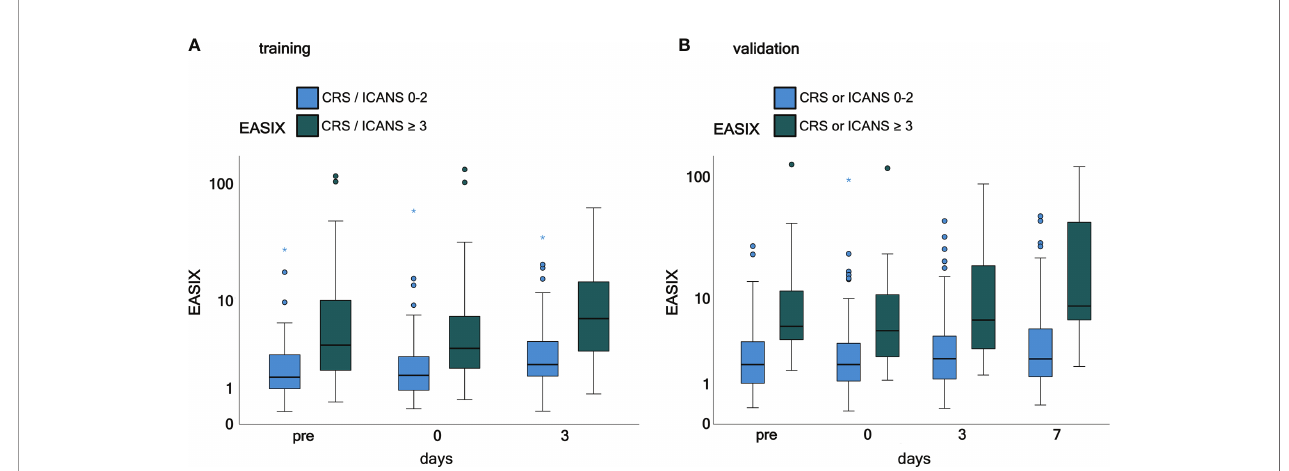
FIGURE 1 | EASIX measurement in the training and validation cohorts grouped according to CRS and ICANS grade. (A) Training cohort. (B) Validation cohort. Patients were grouped according to CRS and/or ICANS grade. EASIX prior lymphodepletion on the day of CAR-T cell application and on day 3 and 7 after application is shown. Training cohort: CRS and/or ICANS grades 0-2 ( n = 61) and ≥ 3 ( n = 32), validation cohort: CRS and/or ICANS grades 0-2 ( n = 100) and ≥ 3 ( n = 21). EASIX, Endothelial Activation and Stress Index; pre, prior lymphodepletion; CRS, cytokine release syndrome; ICANS, immune effector cell-associated neurotoxicity syndrome.